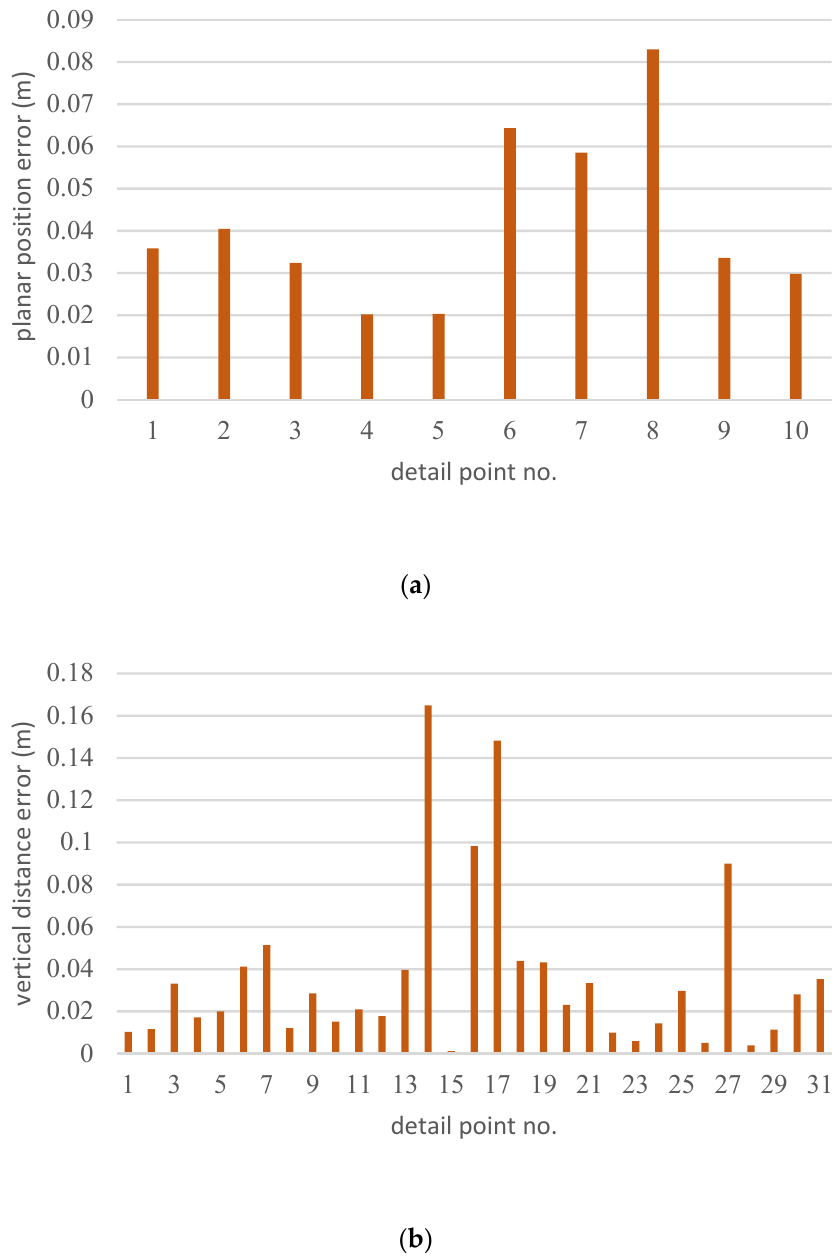
Figure 28. The error analysis of digitized detail line data. ( a ) Planar position analysis. ( b ) Vertical distance error